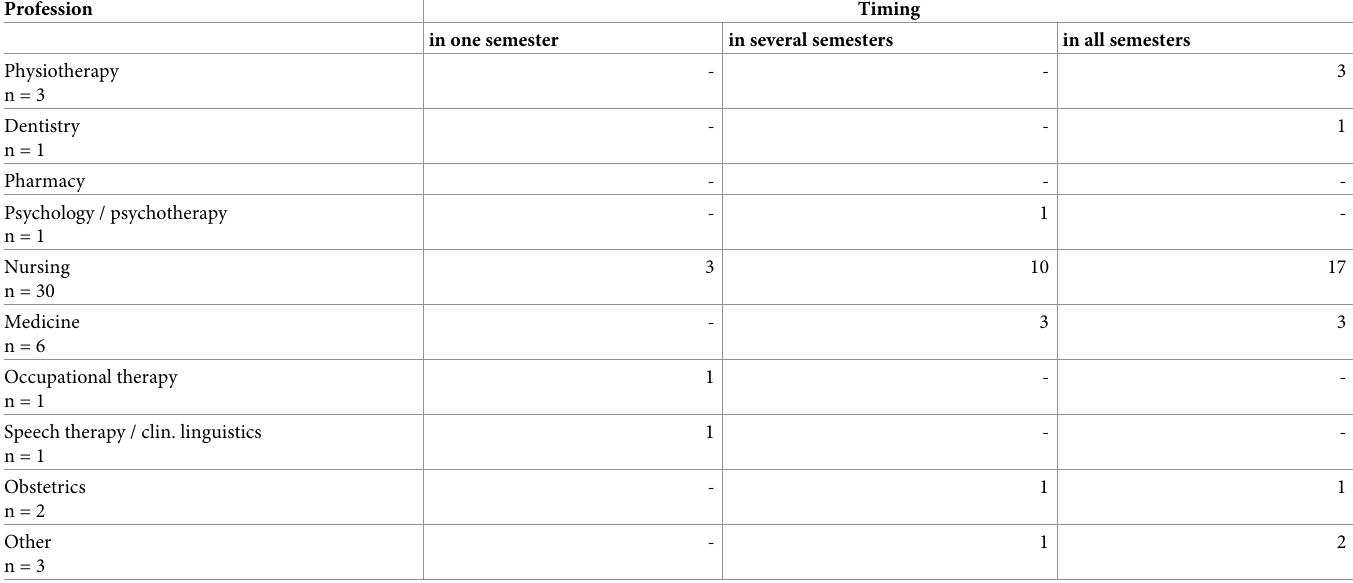
Table 2. Uniprofessional PAL offers per profession and timing [multiple answer options, sample n = 40].